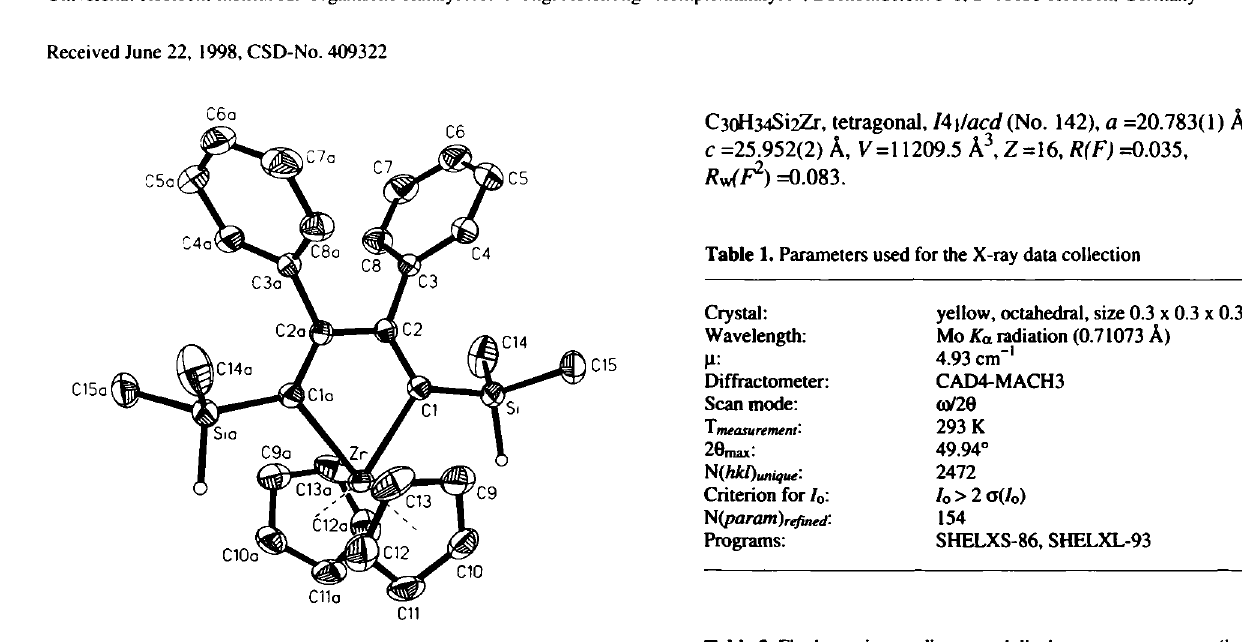
Table 2. Final atomic coordinates and displacement parameters (in